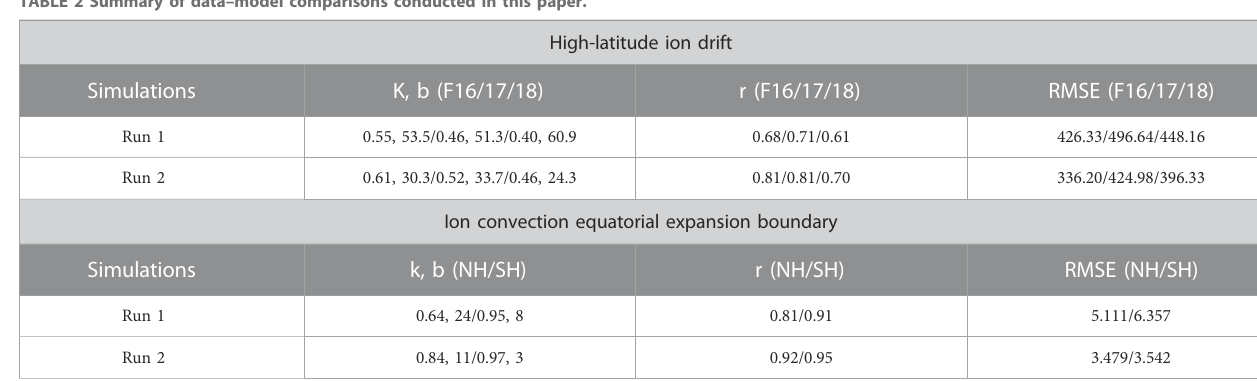
TABLE 2 Summary of data – model comparisons conducted in this